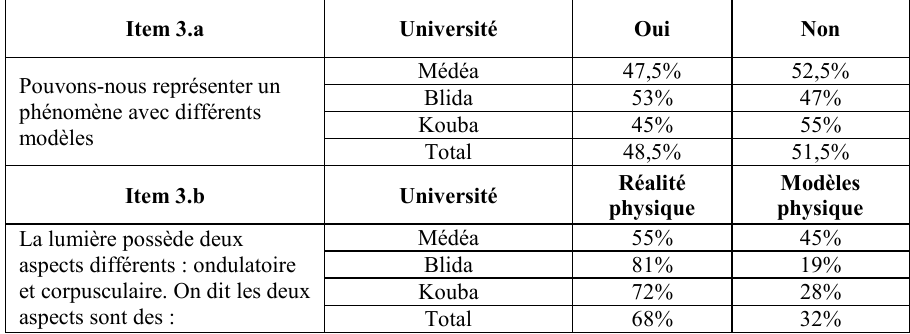
Table 4. Résultats de la cohérence de la perception du modèle. Table 5. Résultats des items 3.a et 3.b : La nature hypothétique et modifiable du